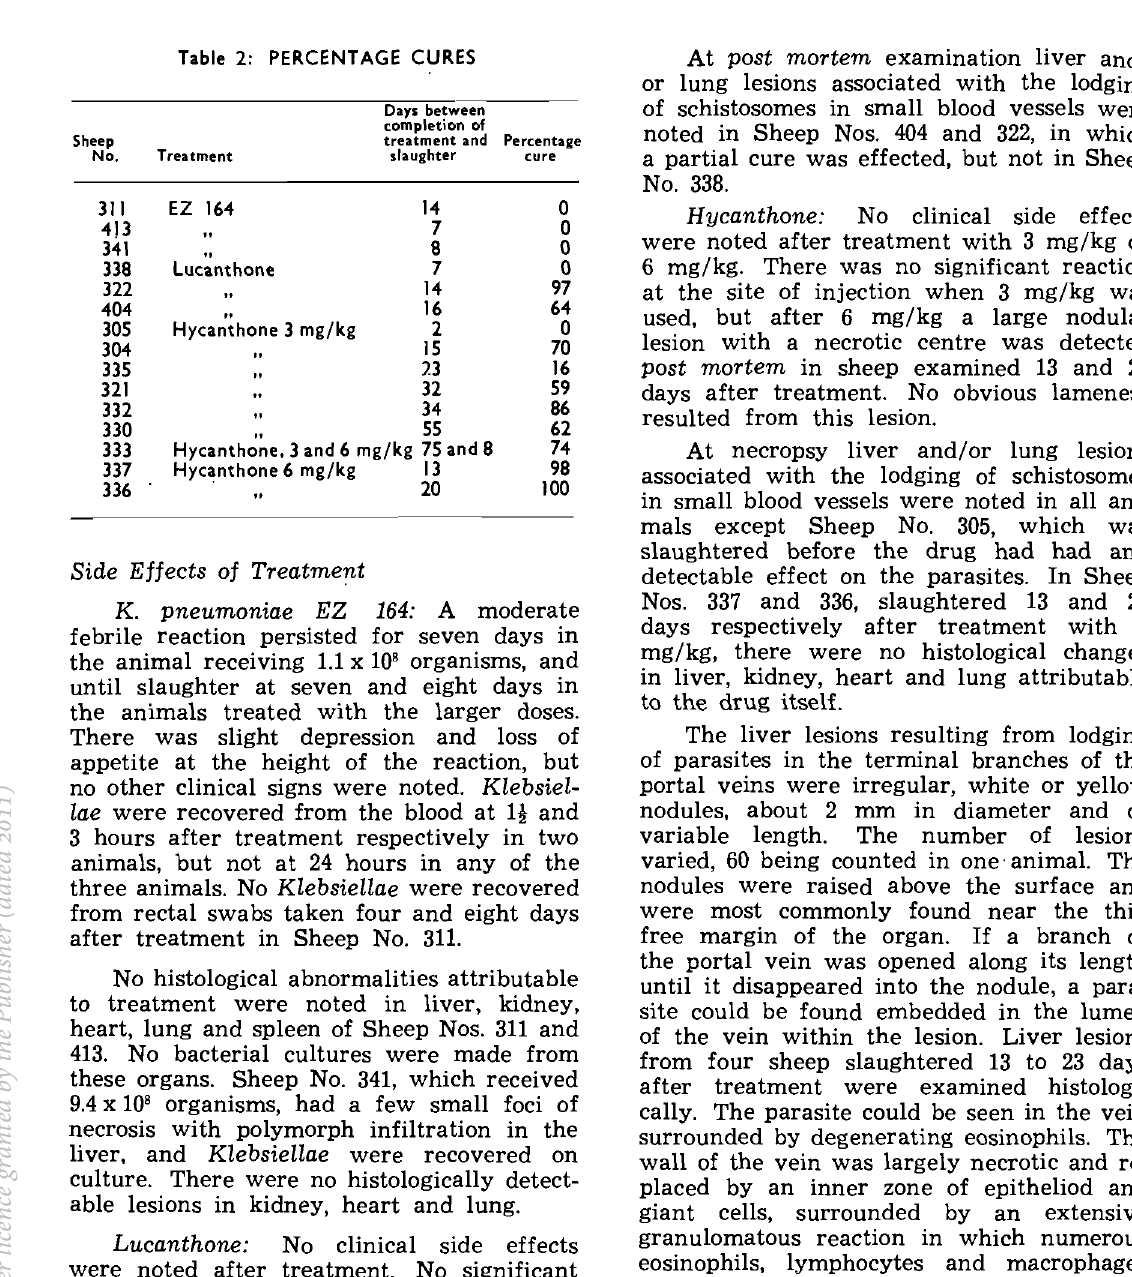
Table 2: PERCENT AGE CURES Sheep treatment and Percentage